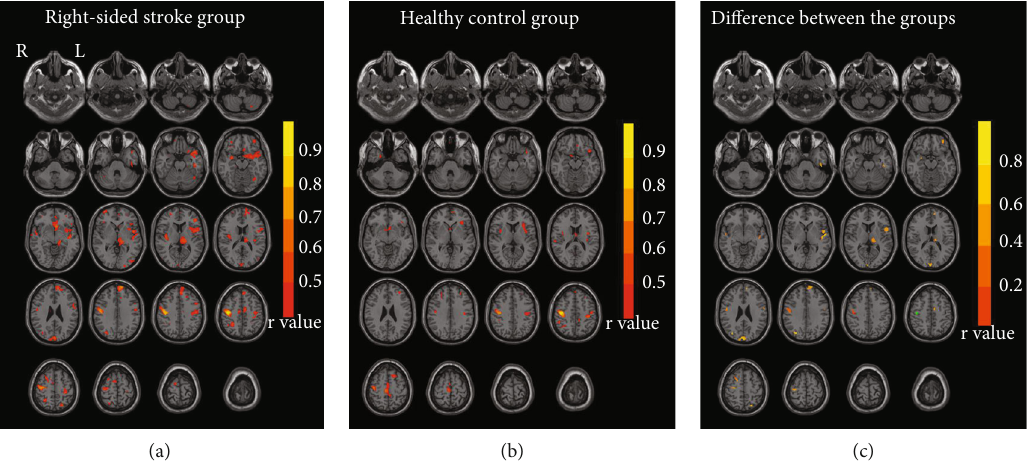
Figure 4: Structural covariance maps and group comparisons in the right-sided stroke patients and healthy controls. (a) Structural covariance map of the ipsilesional M1 (right side) in the right-sided stroke group ( p < 0 : 001 , uncorrected). (b) Structural covariance map of the ipsilesional M1 (right side) in the healthy controls ( p < 0 : 001 , uncorrected). (c) Group comparison between the right-sided stroke group and the healthy controls ( p < 0 : 001 , uncorrected) and the di ff erences in correlation coe ffi cients between the two groups (stroke group minus healthy controls) in the positive brain regions. The cyan circle shows the location of the seed point (the ipsilesional M1). Abbreviations: L =left hemisphere; R =right hemisphere; HC =healthy controls.